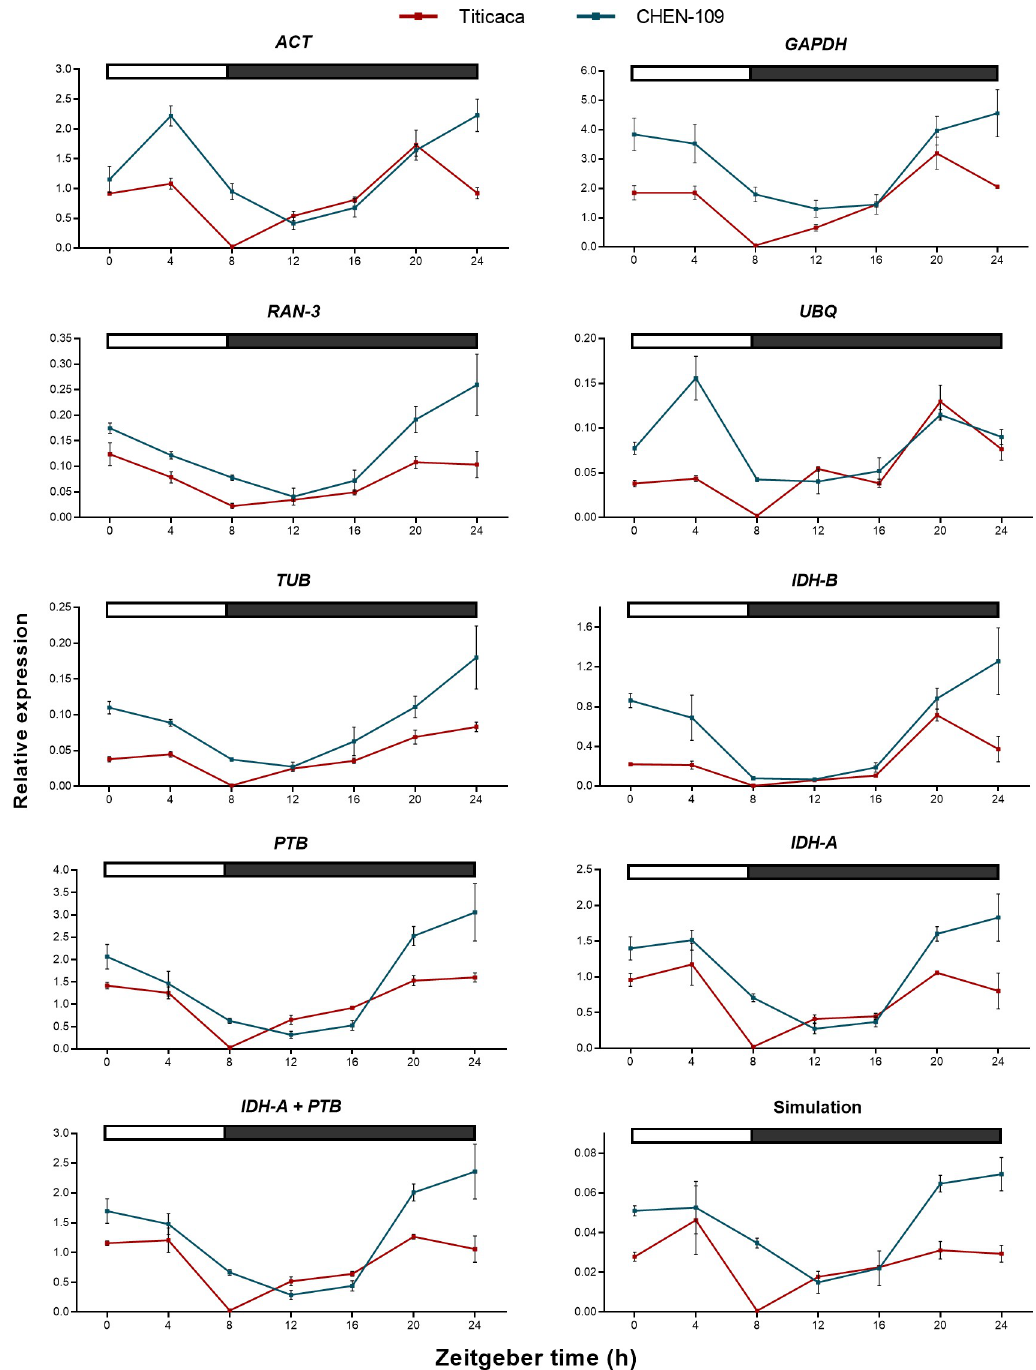
Fig 5. Validation of reference genes using the target gene CqBBX19 . Relative CqBBX19 expression normalized against each candidate gene, the combination of the two best genes for normalization of Titicaca determined by BestKeeper ( IDH-A + PTB ) and a constant Cq value of 20 (Simulation). The bar at the top indicates light (empty box) and dark (filled box) phases. Error bars represent the SEM of three biological replicates.